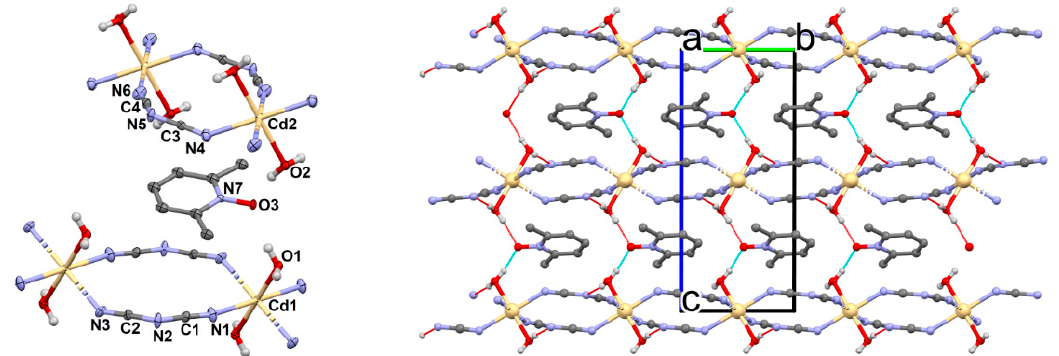
Figure 3. Coordination ( left ) and 1D system ( right ) of complex 3 . Dotted lines indicate H-bonds. (Color code: yellow, Cd; red, O; blue, N; black, C; gray, H.)